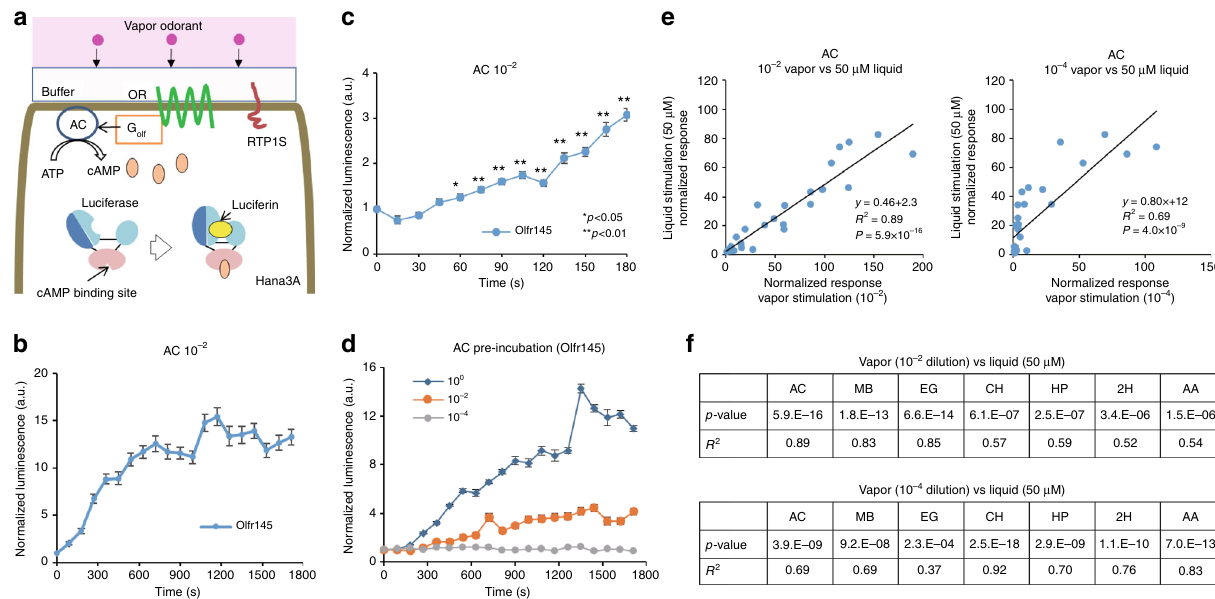
Fig. 3 Vapor detection with GloSensor assay system. a Schematic representing the GloSensor assay in Hana3A showing OR signal transduction pathway. b Real time measurement of each OR activation with 10 − 2 dilution of acetophenone (AC). Luminescence in each well was measured once every 90 s for 20 cycles and the values were normalized with the initial value for each receptor and response of the vector control at the given time point. Error bars indicate s.e.m. ( n = 3). c More frequent (15 s intervals) measurements using Olfr145 and a vector control with 10 − 2 dilution of acetophenone. Error bars indicate s. e.m. ( n = 3). d Olfr145 activation with only pre-incubation of the luminescence measuring chamber with acetophenone. Error bars indicate s.e.m. ( n = 3). e Comparison of the normalized response by vapor and liquid stimulation. A 10 − 2 or 10 − 4 dilution of acetophenone in mineral oil was placed adjacent to the wells for vapor stimulation. Furthermore, 50 μ M of acetophenone was used for liquid stimulation. The straight line is the regression line and R 2 indicates Pearson ’ s correlation coef fi cient. The p -value was calculated from the regression analysis. f Summarize of comparison between vapor (10 – 2 or 10 – 4 dilution) and liquid (50 μ M) stimulation using seven odorants. AC adenylyl cyclase, ATP adenosine triphosphate, cAMP cyclic monophosphate,